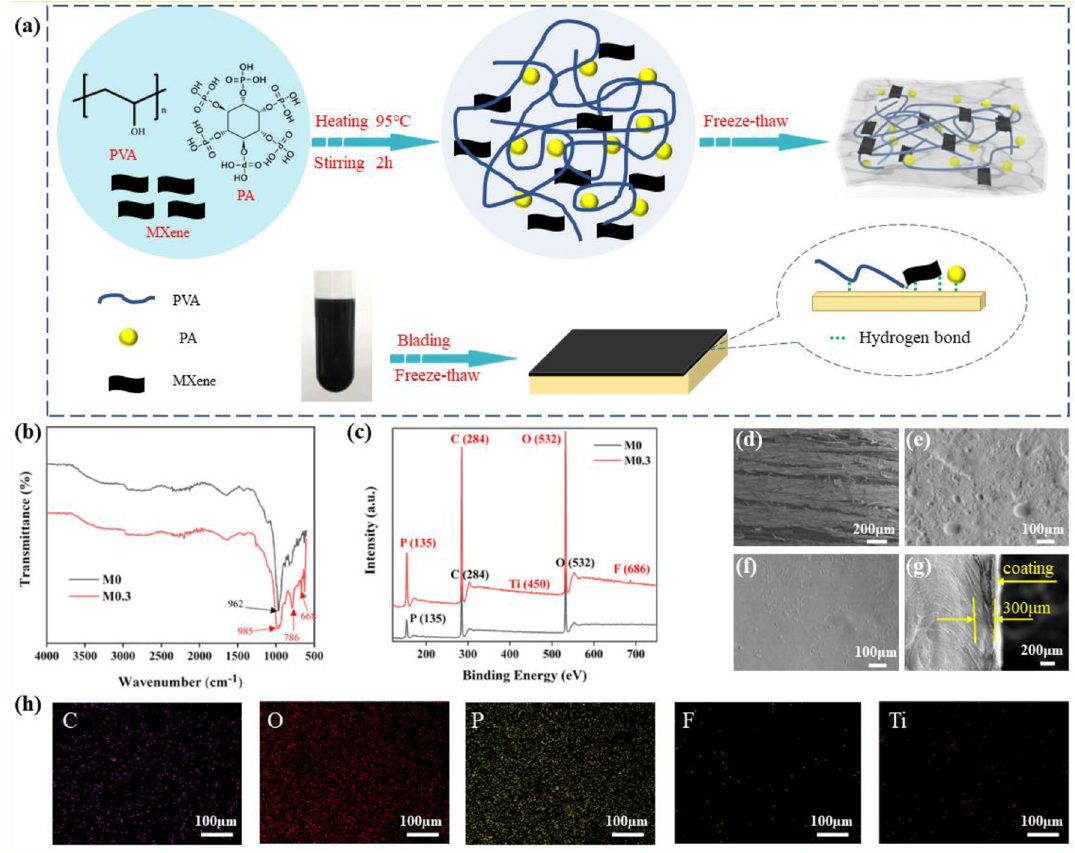
Figure 1. The synthetic process and characterization of M-hydrogel, M-hydrogel-coated and uncoated wood. ( a ) The illustration of hydrogel and hydrogel-coated wood preparation procedures. ( b ) FTIR spectra and ( c ) XPS of M0 and M0.3 hydrogel. SEM image of the surface of ( d ) pure wood, ( e ) M0 hydrogel-coated wood, ( f ) M0.3 hydrogel-coated wood and ( g ) the cross-section structure of M0.3 hydrogel-coated wood. ( h ) EDX of M0.3